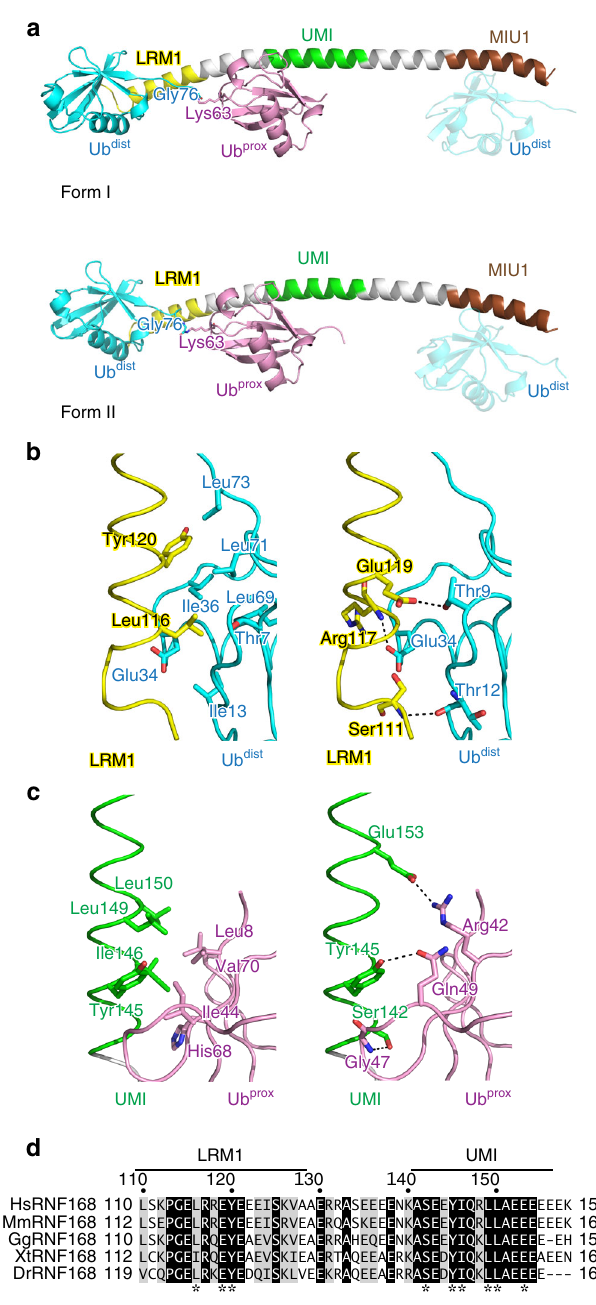
Fig. 2 Structure of the complex between RNF168 UDM1 and K63-Ub 2 . a Overall structure of the complex. The coloring scheme of UDM1 is the same as in Fig. 1. Ub dist and Ub prox of K63-Ub 2 are colored cyan and pink, respectively. The linkage between Gly76 of Ub dist and Lys63 of Ub prox is shown. The MIU1-bound Ub dist from the adjacent complex in the crystal is also shown as a translucent model. b Hydrophobic (left) and hydrogen- bonding (right) interactions between RNF168 LRM1 and Ub dist . The coloring scheme is the same as in a , c Hydrophobic (left) and hydrogen-bonding (right) interactions between RNF168 UMI and Ub prox . The coloring scheme is the same as in a , d Sequence alignment of LRM1 – UMI in human (Hs), mouse (Mm), chicken (Gg), xenopus (Xt), and zebra fi sh (Dr) RNF168 proteins 56 ]. Fully conserved residues are colored white with black background, whereas residues with similar properties (scoring > 0.5 in the Gonnet matrix 57 ) are marked with gray backgrounds. Asterisks represent the residues whose side chains interact with K63